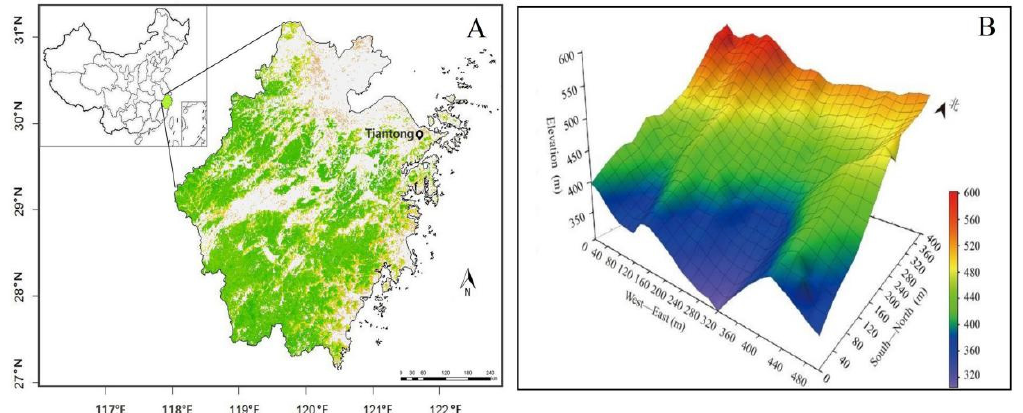
Figure 1. The study area location in Zhejiang Province, China ( A ) and the perspective map of topography of the 20-ha Tiantong forest dynamics plot ( B ).